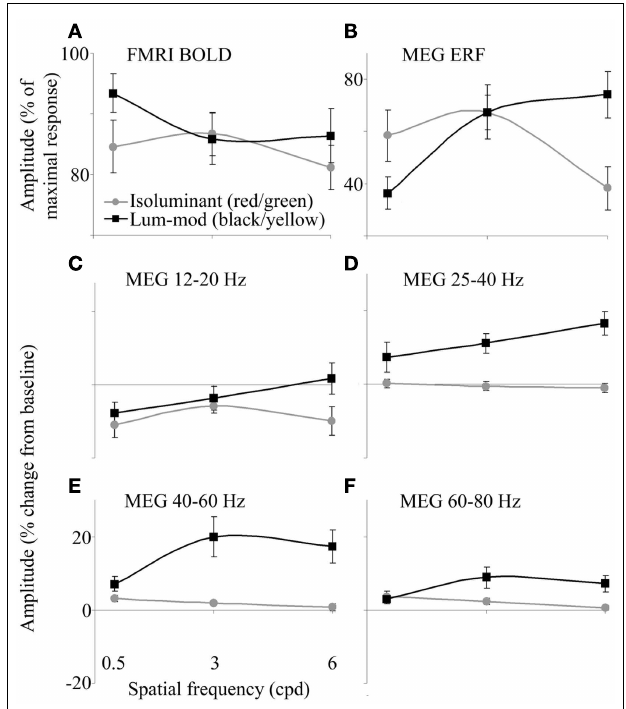
FIGURE 3 | (A) fMRI-BOLD responses determined as a percentage of the largest response for each observer. (B) MEG ERF responses determined as a percentage of the largest response for each observer. (C–F) MEG-measured changes in spectral energy for four frequency bands in the 0.5–2s time period compared with baseline. Error bars show the SEM.